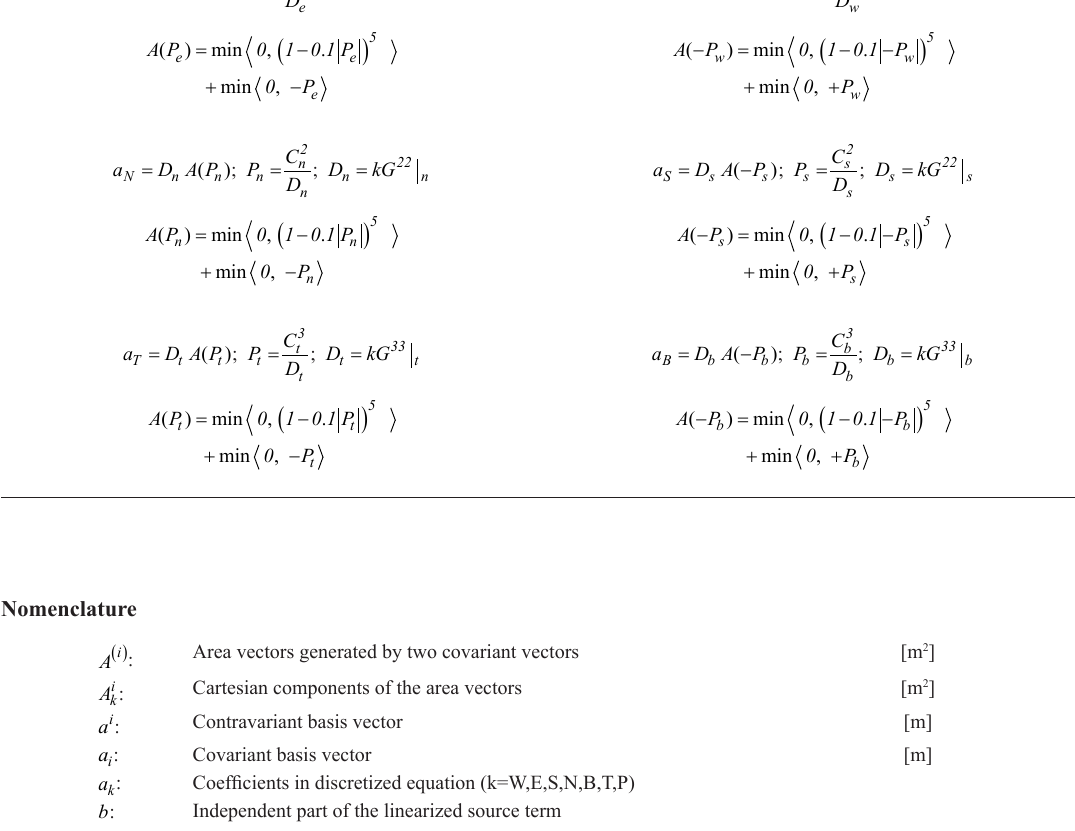
Table A1. Power law coefficients for the discretized general conservative equation. ( ) =